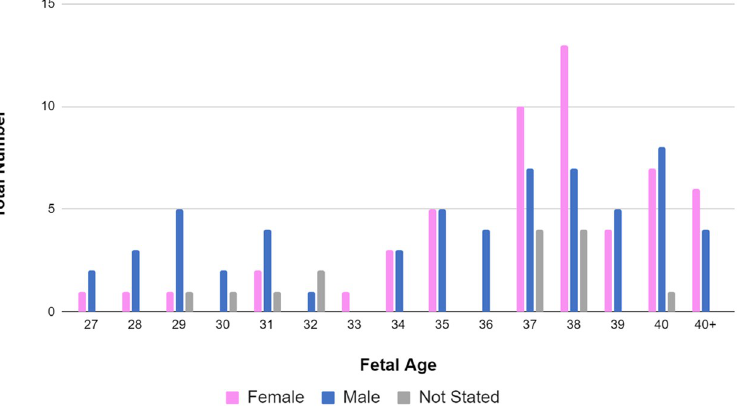
Fig 10. Distribution of gestational age and the fetal gender of the test group. The general distribution of fetal age of the test group can be observed in this figure. The distribution is distinguished based on the gender of the fetus. the height of each bar indicates the number of fetuses in that category. The gestation age of the test group varied from 27 weeks to 40+ weeks and a higher number of fetuses aged above 37 weeks can be observed.